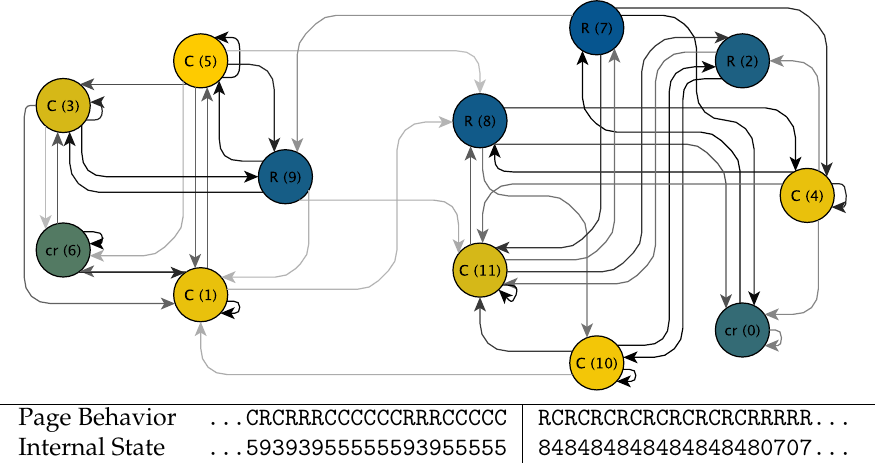
Figure 1. Top panel: Hidden Markov model for cooperation and conflict on the George W. Bush page. States are labeled by the probability of emitting each of the two output symbols; “C” ( P ( C ) > 0.8, lighter yellow), “R” ( P ( R ) > 0.8, darker blue) or “cr” (otherwise). Edge weights show transition probabilities; the lightest lines, connecting the two subspaces, correspond to probabilities of order 10 − 4 . Despite its complexity, the system is dominated by a transition logic that, on short timescales, confines the system to one of two separate modules with a high density of internal transitions. Bottom panel: below the diagram, as an example of our method, we show the Viterbi reconstruction in the neighborhood of one of the sixteen between-subspace transitions in our data. As the system wanders, during this period, among internal States 5, 9, 3, 8 and 4, it emits the symbols C and R probabilistically depending on which particular state it is in. On 8 November 2004 at 9:11 UTC (Coordinated Universal Time), long runs of cooperation and conflict gave way to more rapid-fire conflict and vandal-repair as the system crossed from the left module to the right, via the bridge between State 5 and State